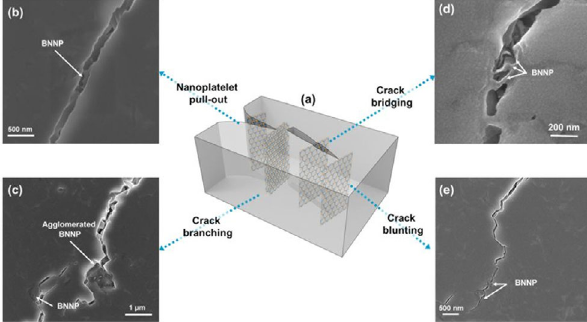
Fig. 9 Microstructure of a ceramic composite reinforced with BN. Reproduced with permission from Ref. [28], © Springer Nature 2016.